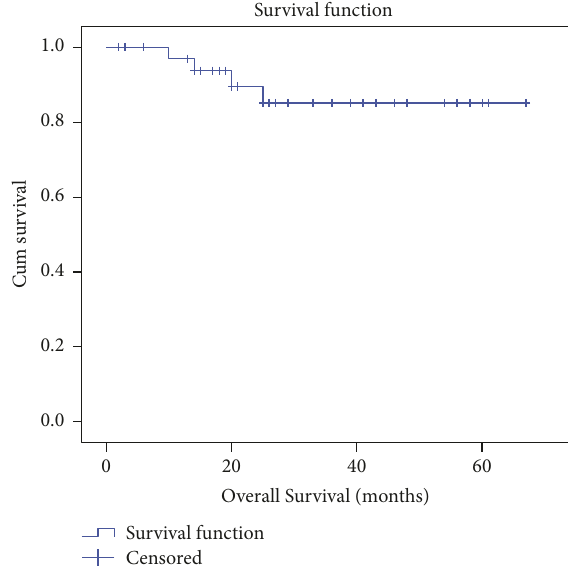
Figure 1: Kaplan-meier curve-overall survival for all cases.